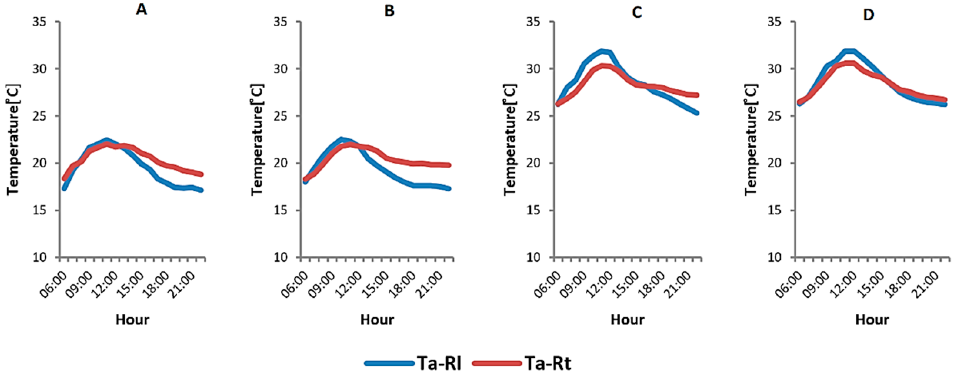
Figure 4. The comparison of outdoor and indoor air temperatures in the transitional season from dry to wet seasons: ( A ) exposed stone houses in the mountains, ( B ) wooden houses in the mountains, ( C ) exposed brick houses on beaches, and ( D ) wooden houses on beaches.